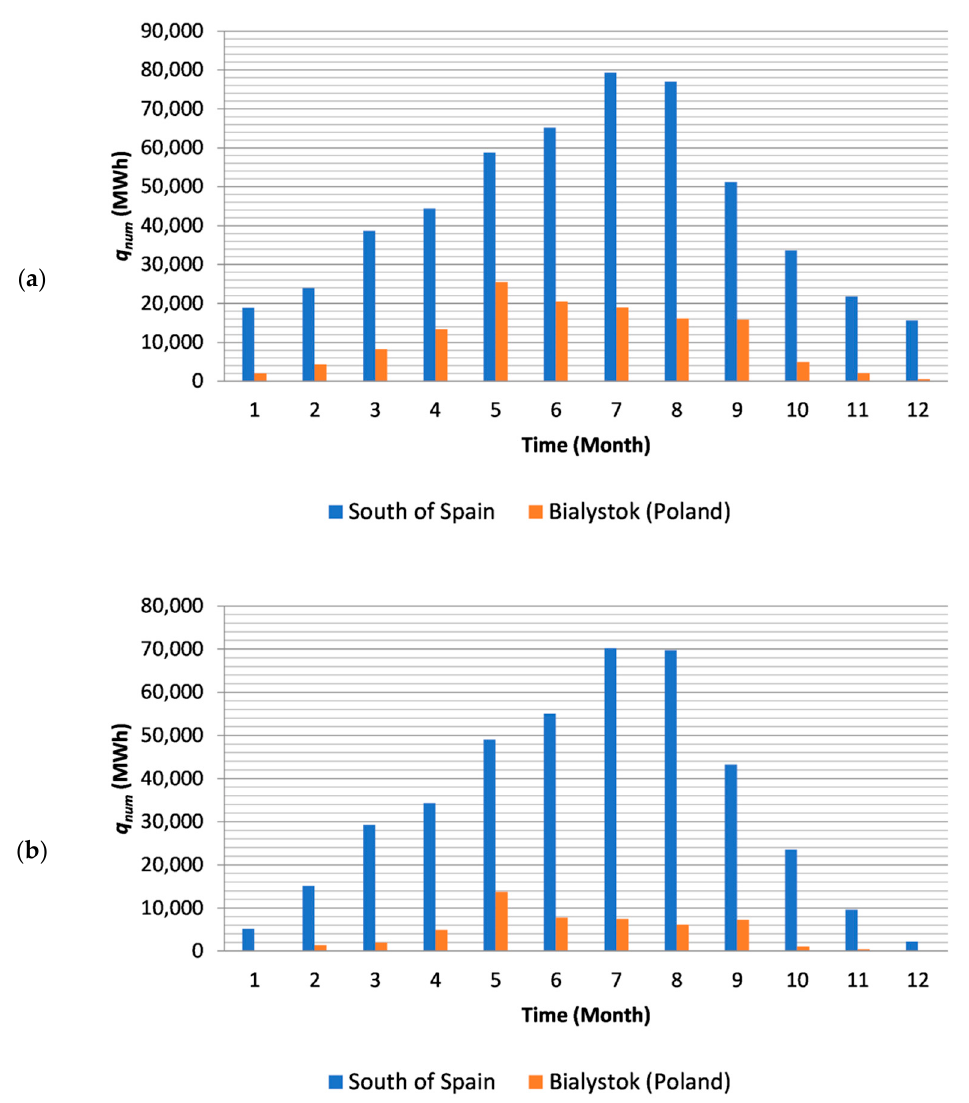
Figure 12. Annual heat produced by parabolic solar collectors for variants A ( a ) and B ( b ). Table 4. Annual heat produced by solar collectors in Spain (Cordoba) and Poland (Bialystok).